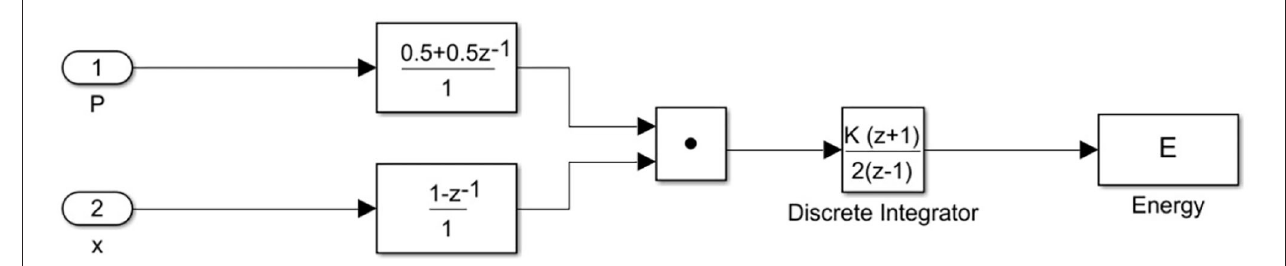
FIGURE 3 | Block diagram for energy